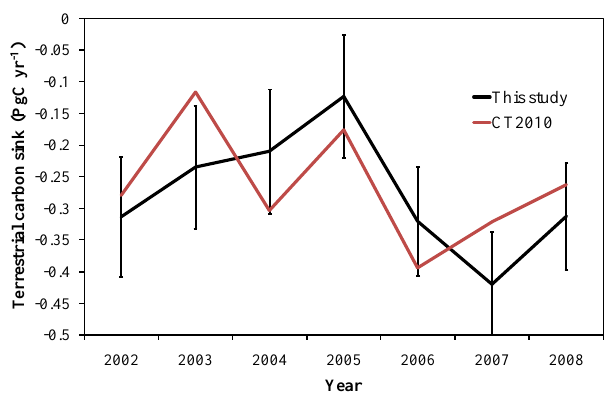
Fig. 6. Inter-annual variations of the terrestrial ecosystem carbon sink in China (2002 - 2008)